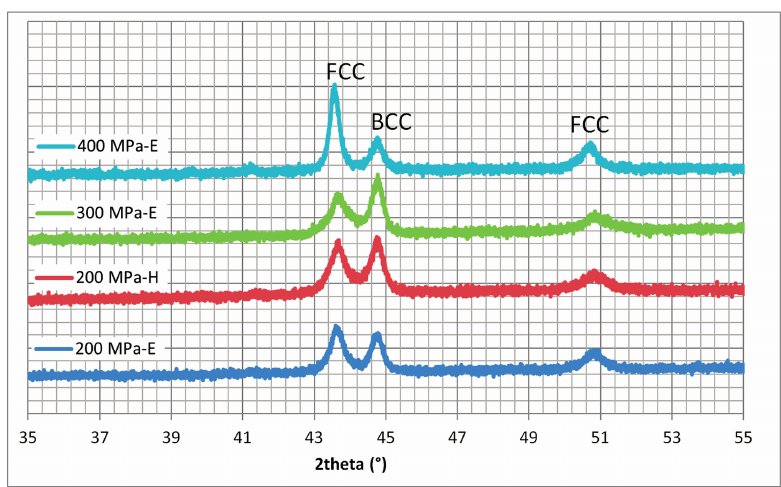
Figure 5. X-ray diffraction patterns of FeCoNiCuAl samples (Y-axis: arbitrary units) processed in predominant electric (E) or magnetic (H) field regions of the applicator (240 W, 5800 GHz), confirming the formation of FCC and BCC solid solutions.